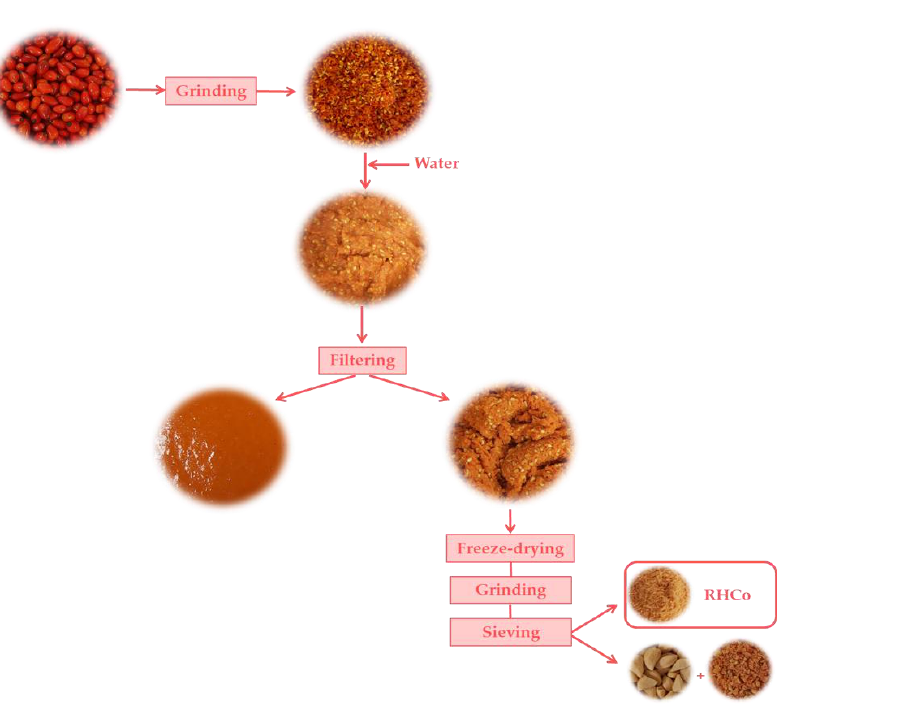
Figure 2. Scheme of rose hips co-product (RHCo) obtaining.